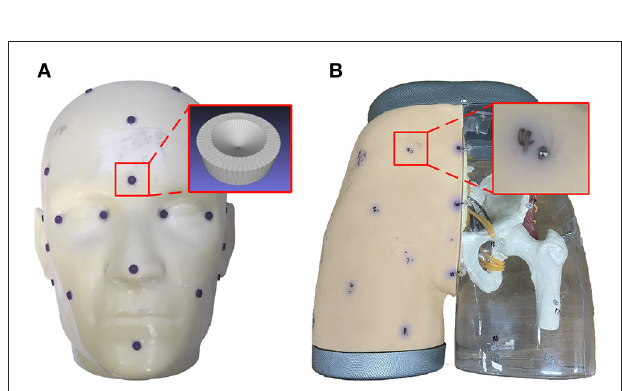
FIGURE 9 | Models designed for the experiments: (A) head phantom; and (B) hip phantom.